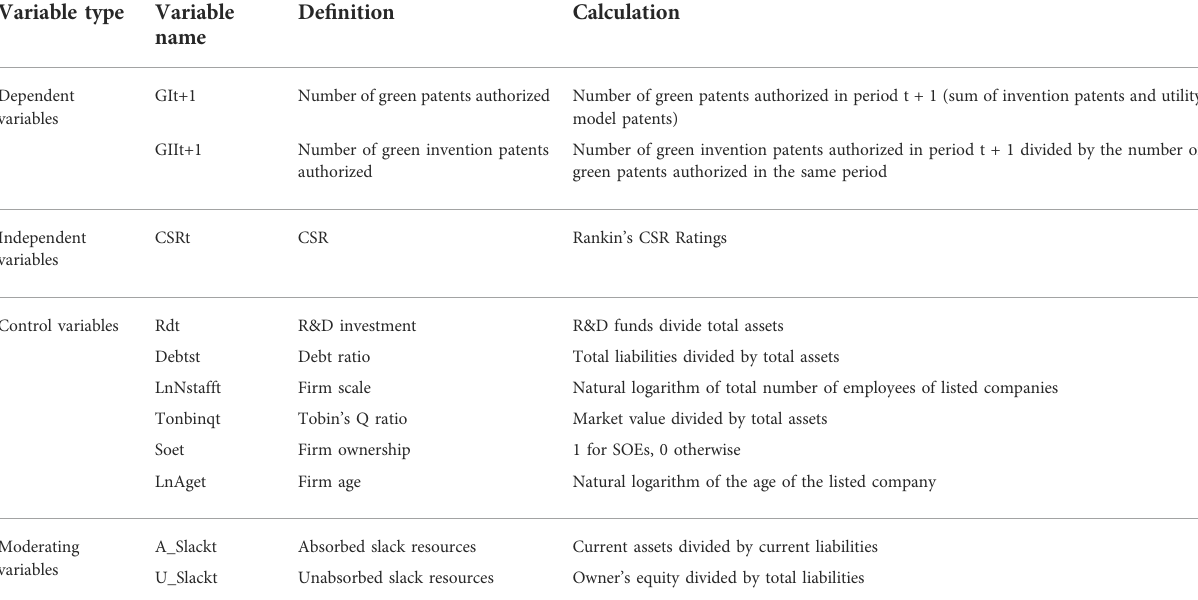
TABLE 1 Variable de fi